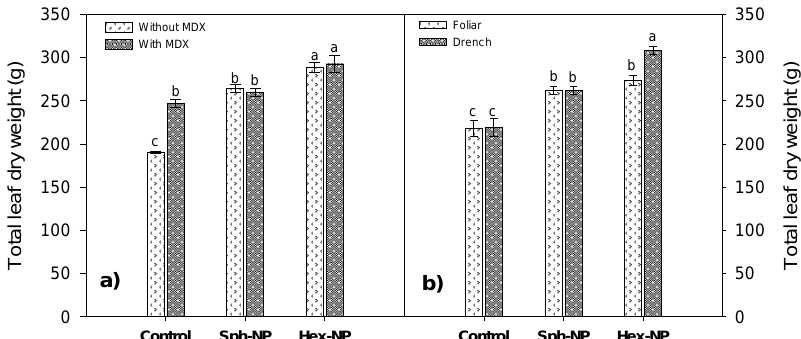
Figure 9. Effect of ZnO-NPs application on leaf dry weight. ( a ) Morphology and maltodextrin (MDX) modification interaction, ( b ) morphology and application method interaction. Bars represent the standard error of the mean. Different letters indicate significant differences according to Tukey´s multiple comparison test ( p < 0.05).